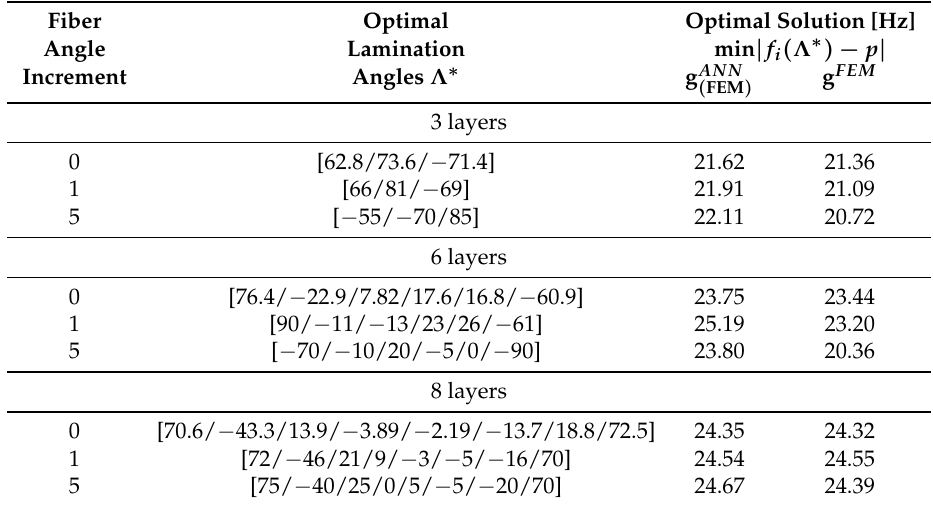
Table 8. Optimization of the distance between natural frequencies and p = 70 Hz using MODEL1 with a different number of